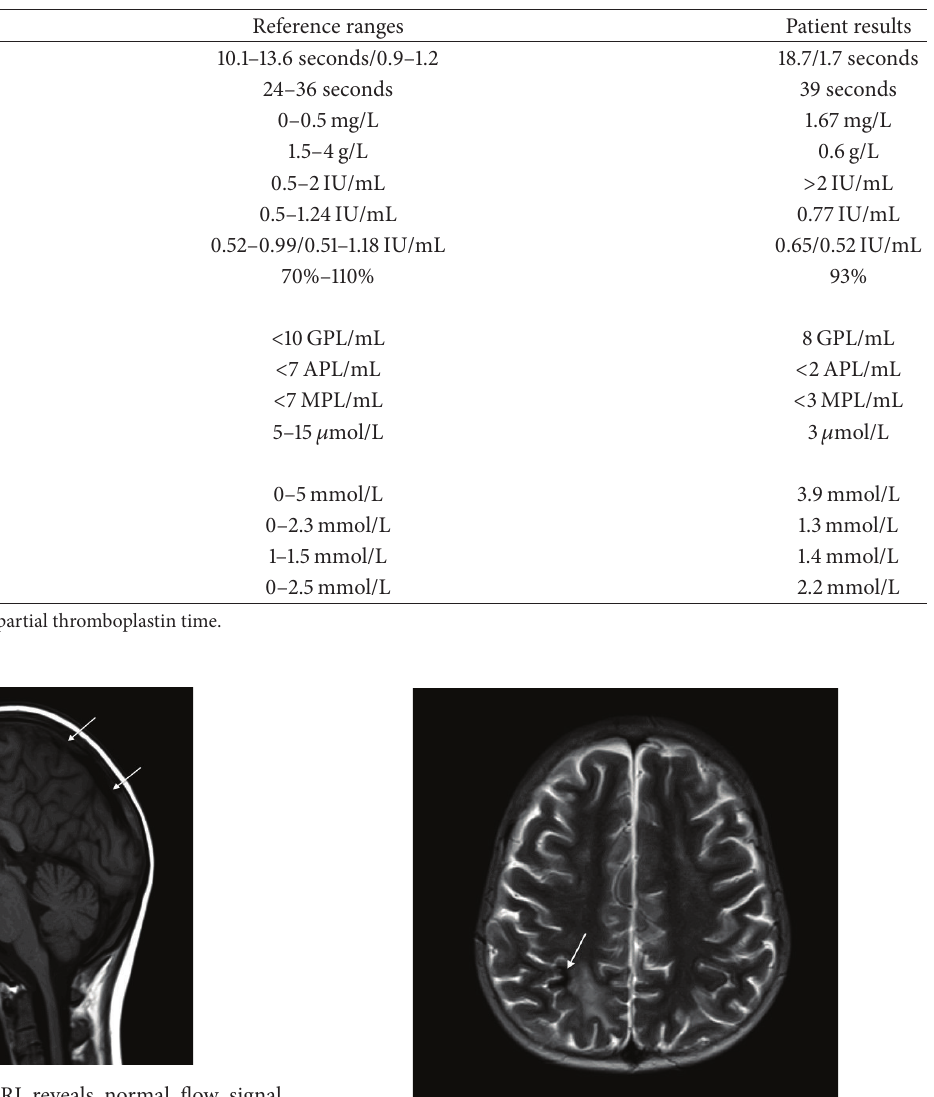
Table 1: Laboratory parameters 3 weeks after PEG-Asparginase therapy.